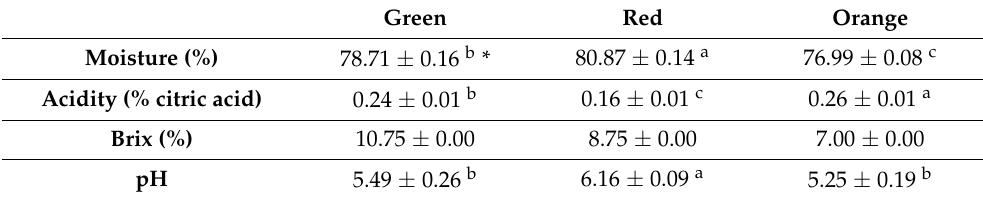
Table 1. Physicochemical characteristics of Opuntia ficus-indica roots.